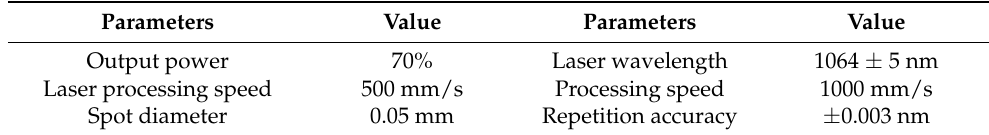
Table 4. Laser processing parameters.